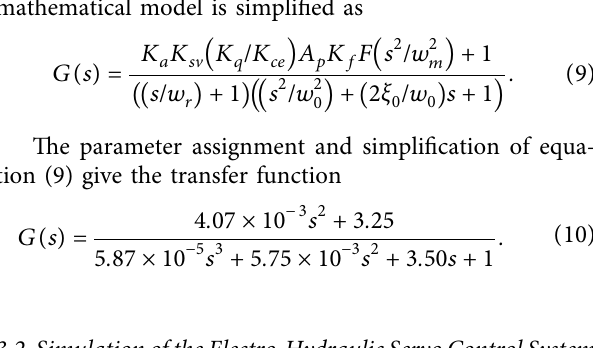
Figure 6: System step response